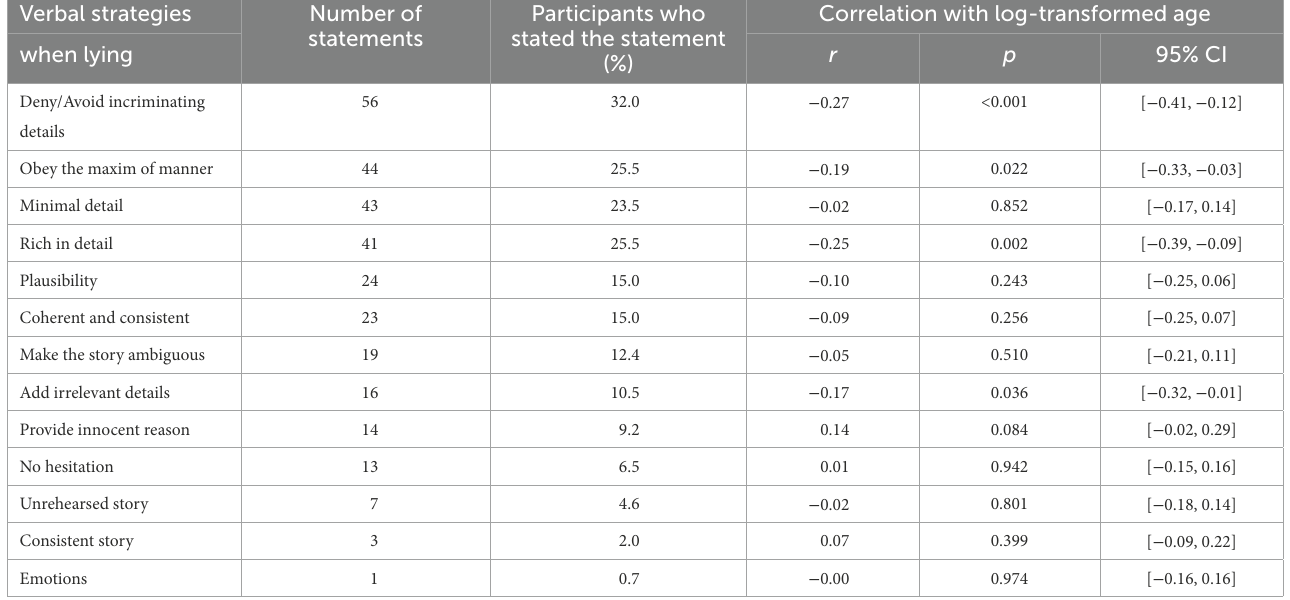
TABLE 2 Verbal strategies when lying, the number of statements, percentage of participants using statements, and correlation with log-transformed age ( N = 153). Verbal